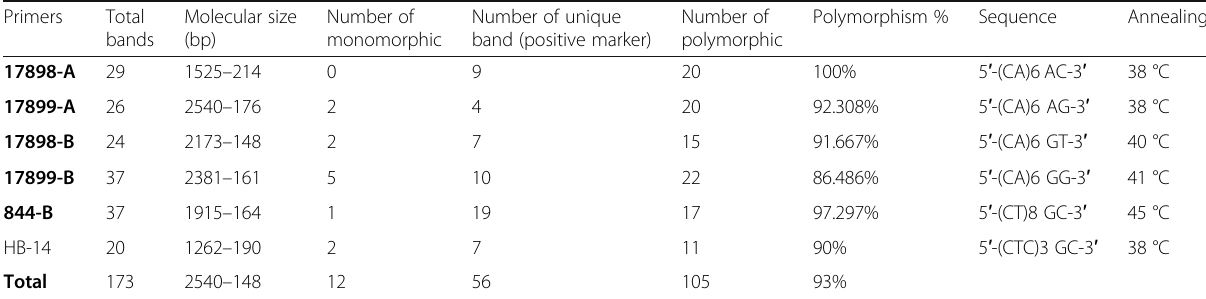
Table 6 Band variation and polymorphism percentage in seven wheat lines using the six ISSR primers